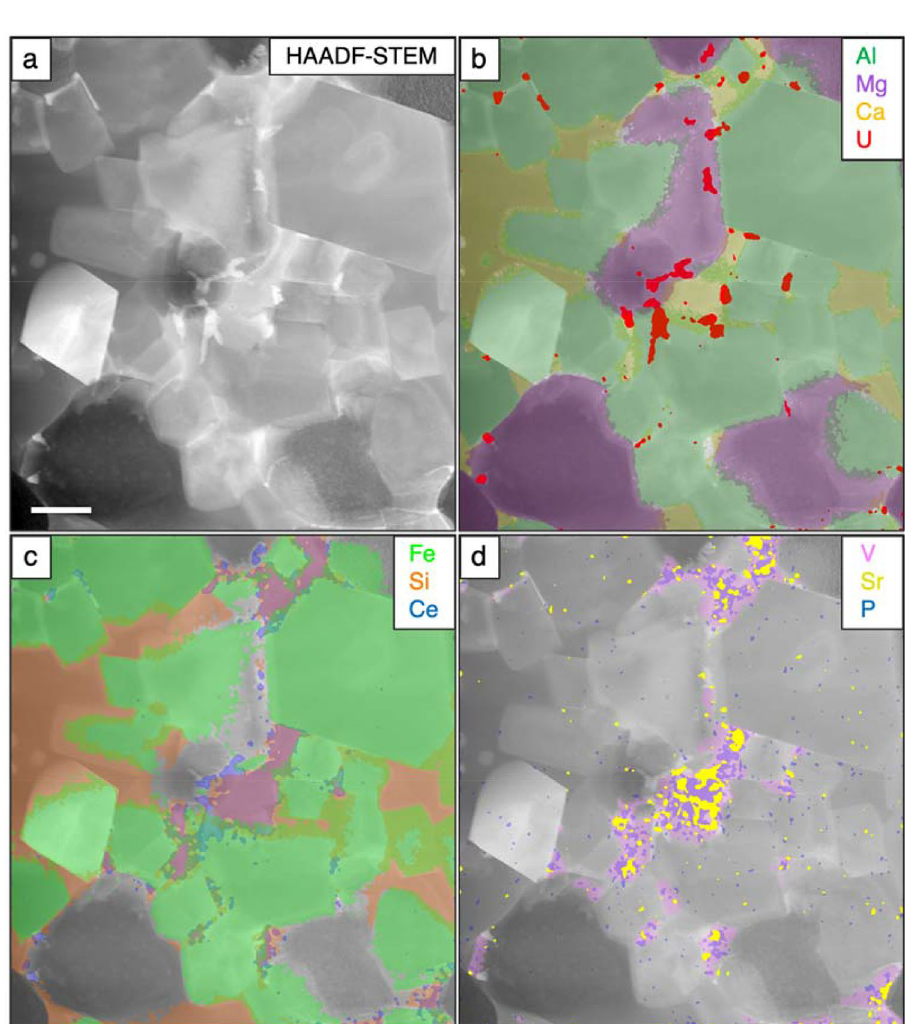
Figure 3. HAADF-TEM images ( a ) greyscale, ( b ) false color element images of Al (green), Mg (purple), Ca (yellow) and U (red), ( c ) false color element images of Fe (green), Si (orange) Ce (blue), and ( d ) V (pink), Sr (yellow) and P (blue)—where P and Sr are coincident, P appears as a pale purple. Scale bar in ( a ) is 500